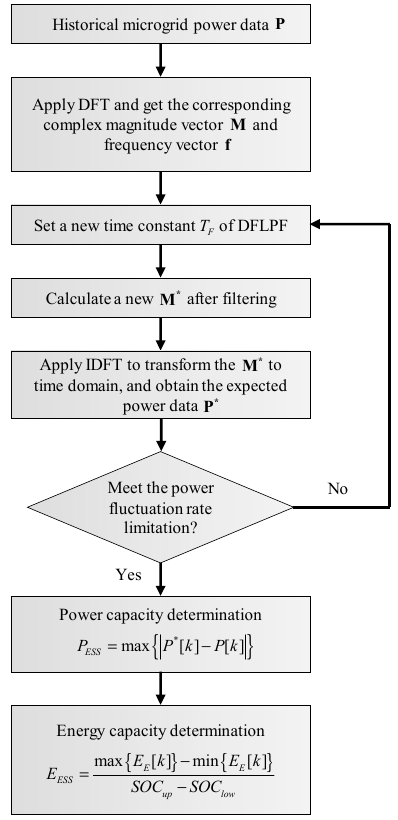
Figure 6. Procedure of ESS capacity sizing.